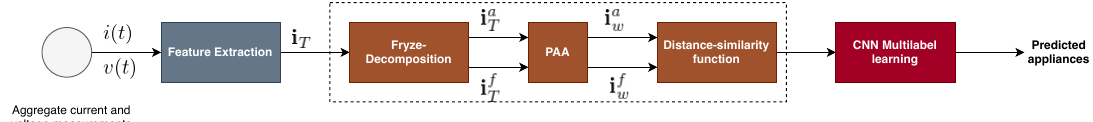
Figure 1. The block diagram of the proposed method. The dotted block is the pre-processing block where PAA stand for Piecewise Aggregate Approximation, a dimension reduction method for high-dimensional time series